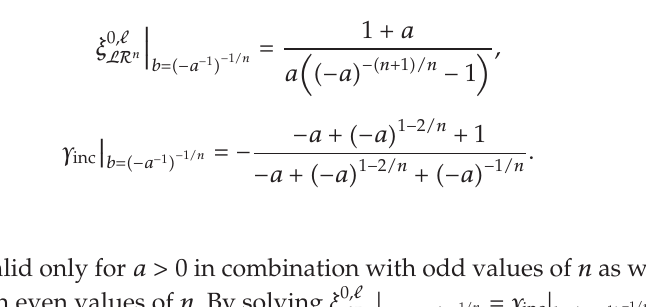
Figure 3 (cid:7) a (cid:8) corresponds to a value of b , which lies between the intersection of γ inc with the boundary of a periodic region and the stability boundary belonging to that periodic region. At values of b , which are not between such a point of intersection and the corresponding stability boundary, all bifurcation diagrams of the chaotic domain calculated for constant values of a and b will look similar to Figure 3 (cid:7) b (cid:8) . They will contain at least a two-band attractor, which is adjacent to the region of period increment with coexisting attractors